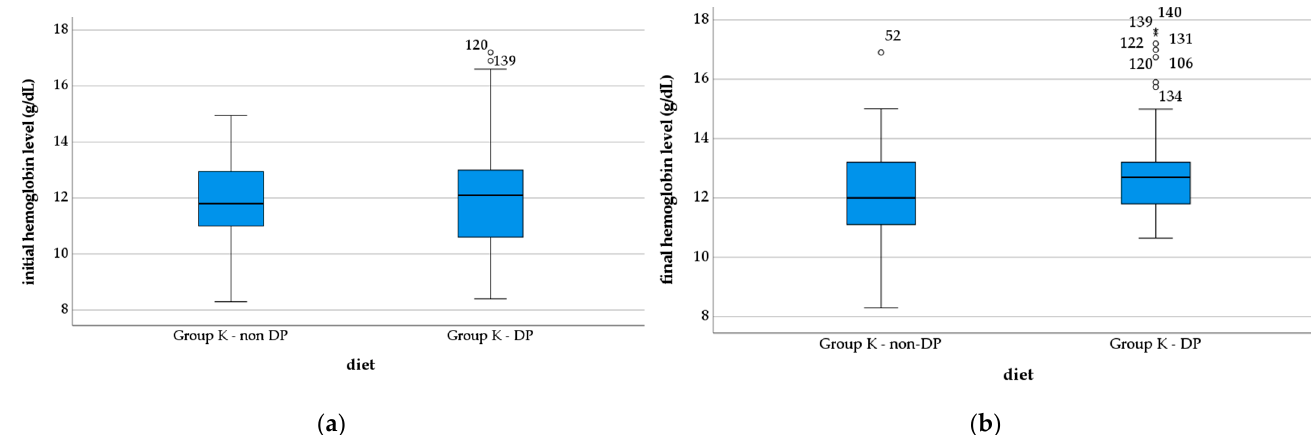
Figure 6. Evolution of the hemoglobin level in the study groups: ( a ) initial vales; ( b ) final values. *, extreme outliers; o, mild outliers.